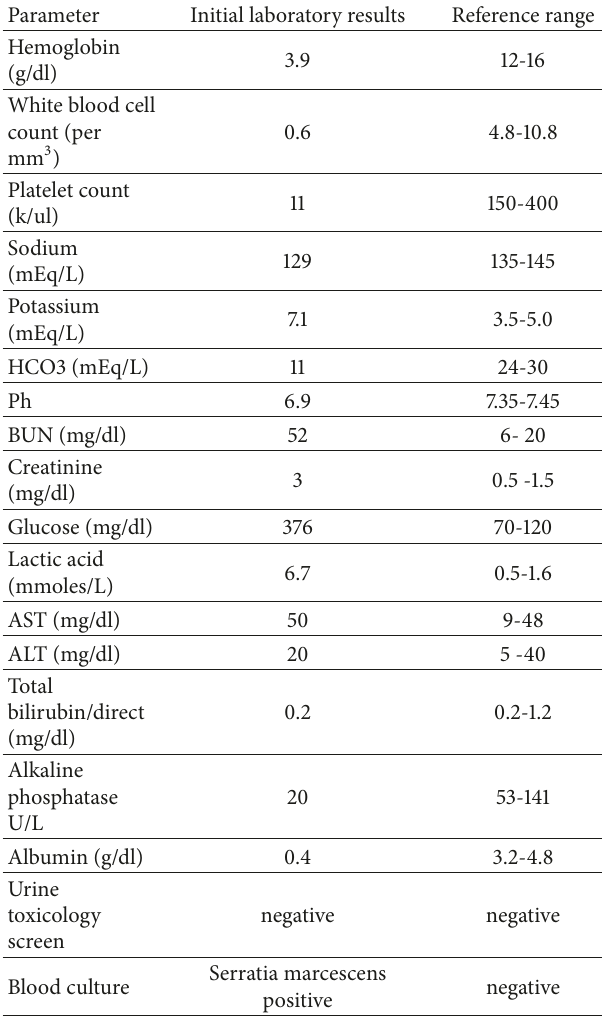
Table 1: Initial laboratory